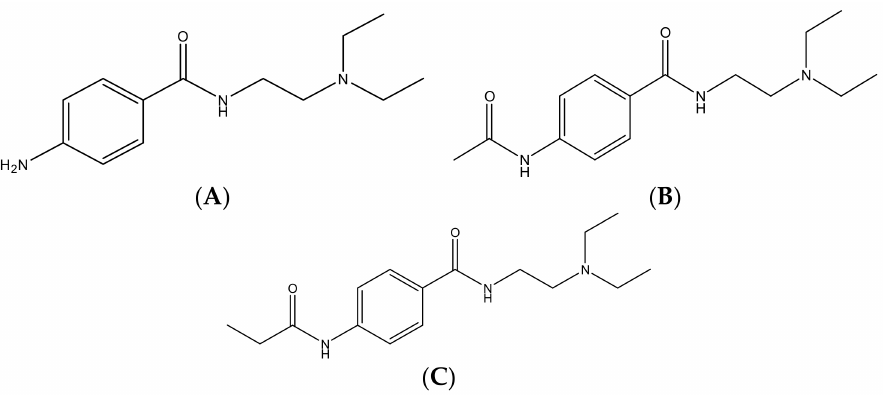
Figure 1. Chemical structures of ( A ) procainamide; ( B ) N -acetylprocainamide; and ( C ) N -propionylprocainamide (the Internal Standard,